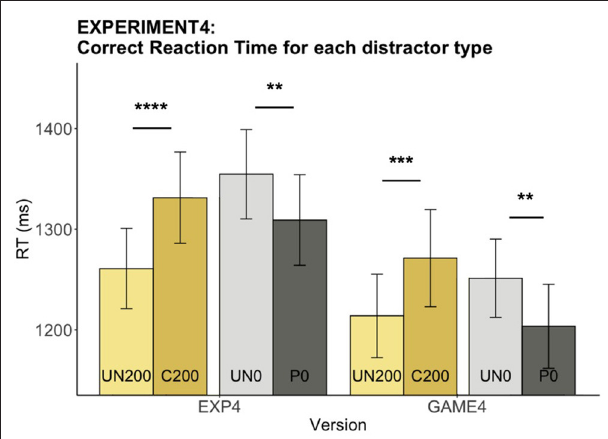
FIGURE 10 | Experiment 4: Reaction time for each distractor type in both versions. The bar charts indicate mean RTs while overlaid error bars show 95% confidence intervals. The distractor conditions are color-coded. UN_200 is the baseline condition for C_200 and UN_0 is the baseline condition for P_0. Asterisks indicate that mean RT for the corresponding condition differs significantly from its baseline condition mean RT (** p < 0.01. *** p < 0.001, **** p < 0.0001).